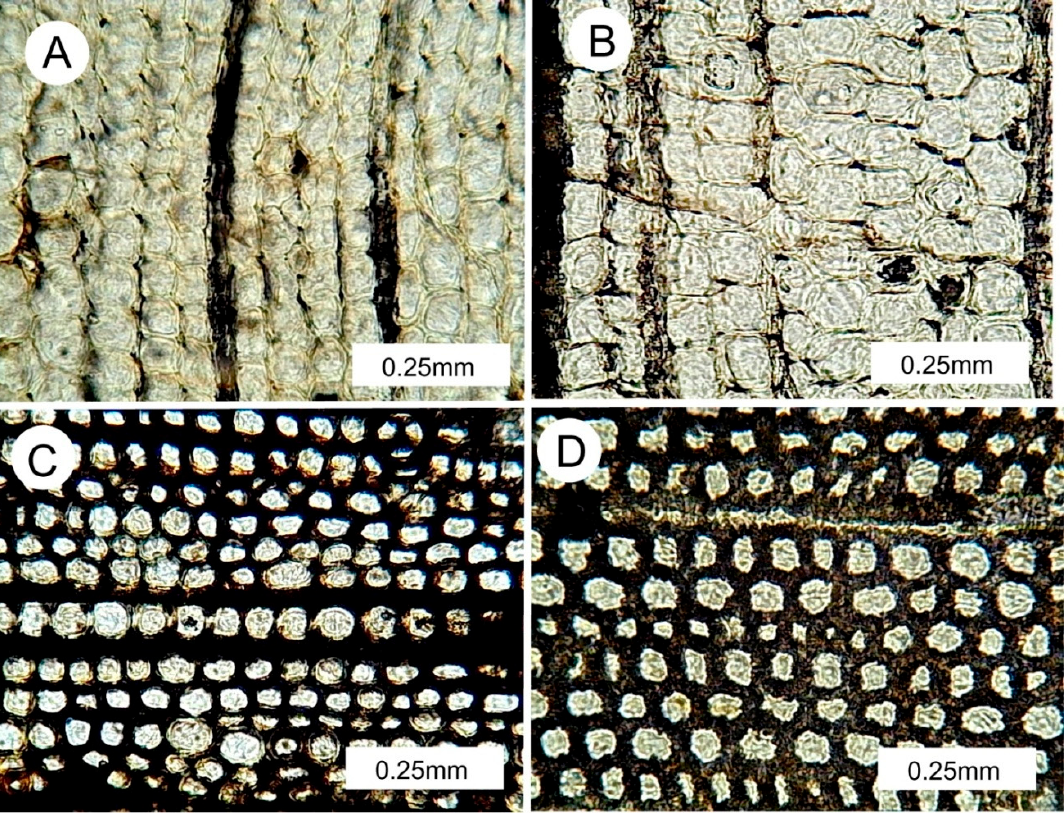
Figure 10. Transmitted light optical photomicrographs of thin sections of transverse views of Las Crucitas fossil wood. The thickness is approximately 30 microns. The absence of vessels is an indication the woods are all from gymnosperms. ( A ) Specimen LC- B. ( B ) Specimen LC –C. ( C ) Specimen LC-E. ( D ) Specimen LC-B. Cell lumina are filled with quartz. In specimens A & B, cell walls are mineralized with transparent quartz. Specimens LC-C and LC- D have dark colored cell walls that appear to consist of a combination of amorphous opal and relict organic matter.